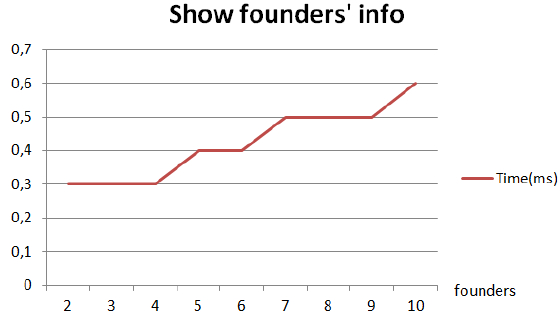
Fig. 5 Efficiency analysis of the founder’s info